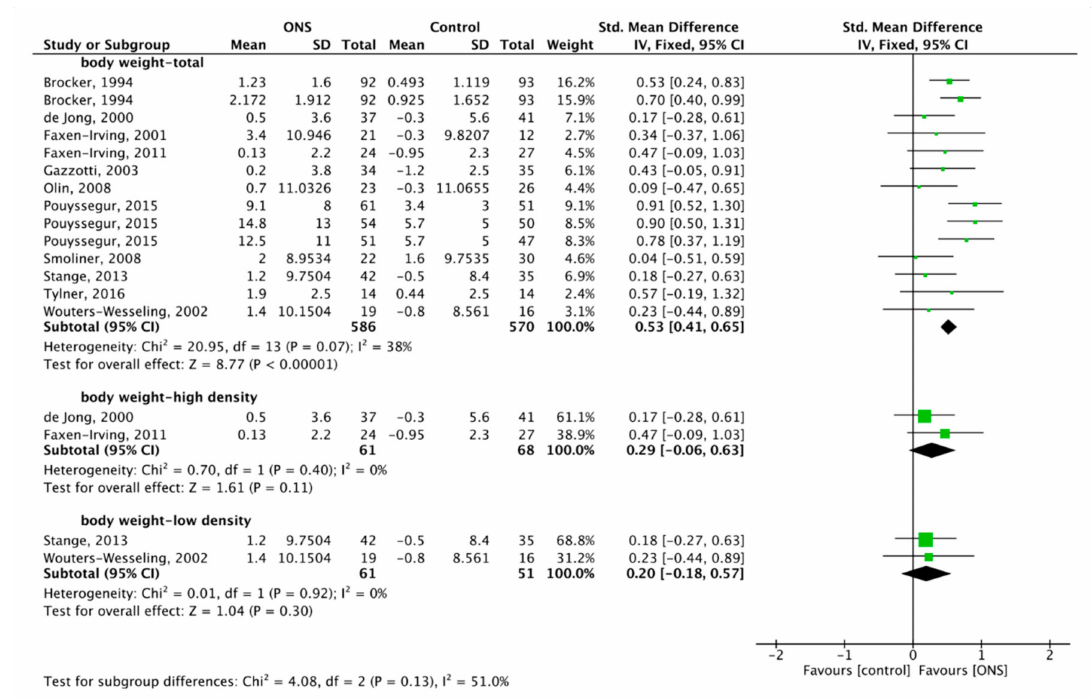
Figure 10. Forest plot comparing the effect of ONS on body weight, and subgroup analysis.